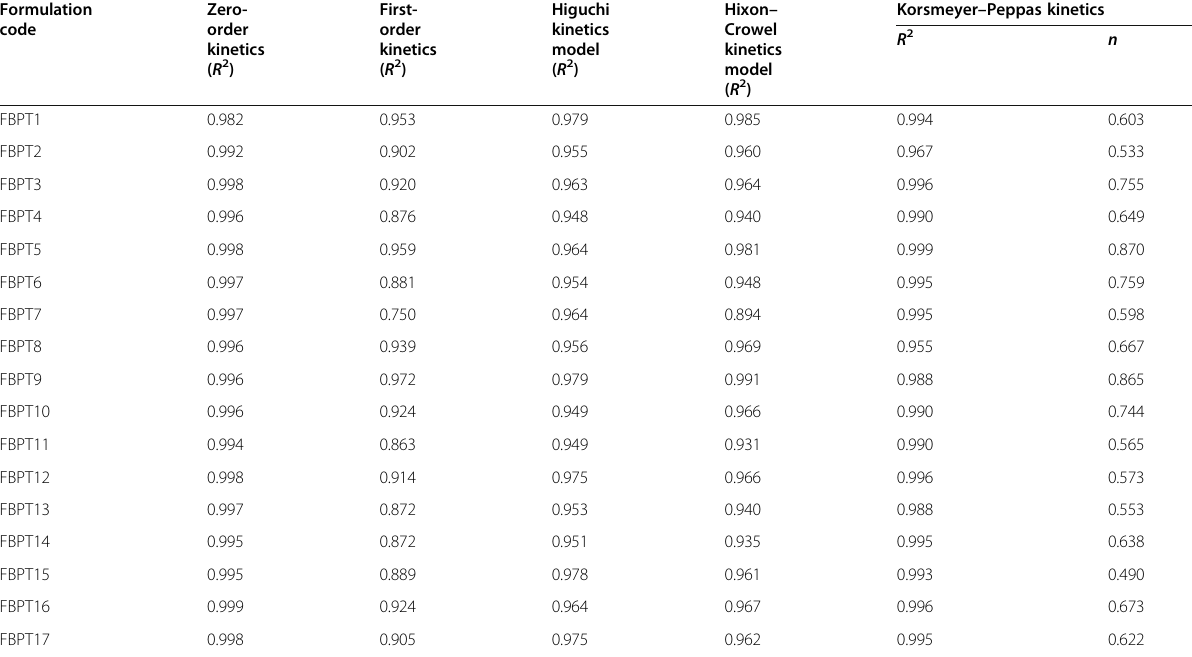
Table 7 Model fitting kinetics for in vitro release profile from different transdermal films Formulation